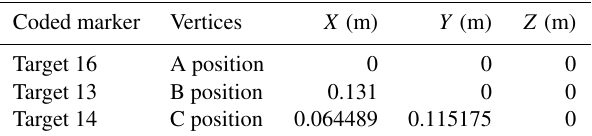
Table 1. Local coordinates for each vertex of a triangle-coded con- trol target.